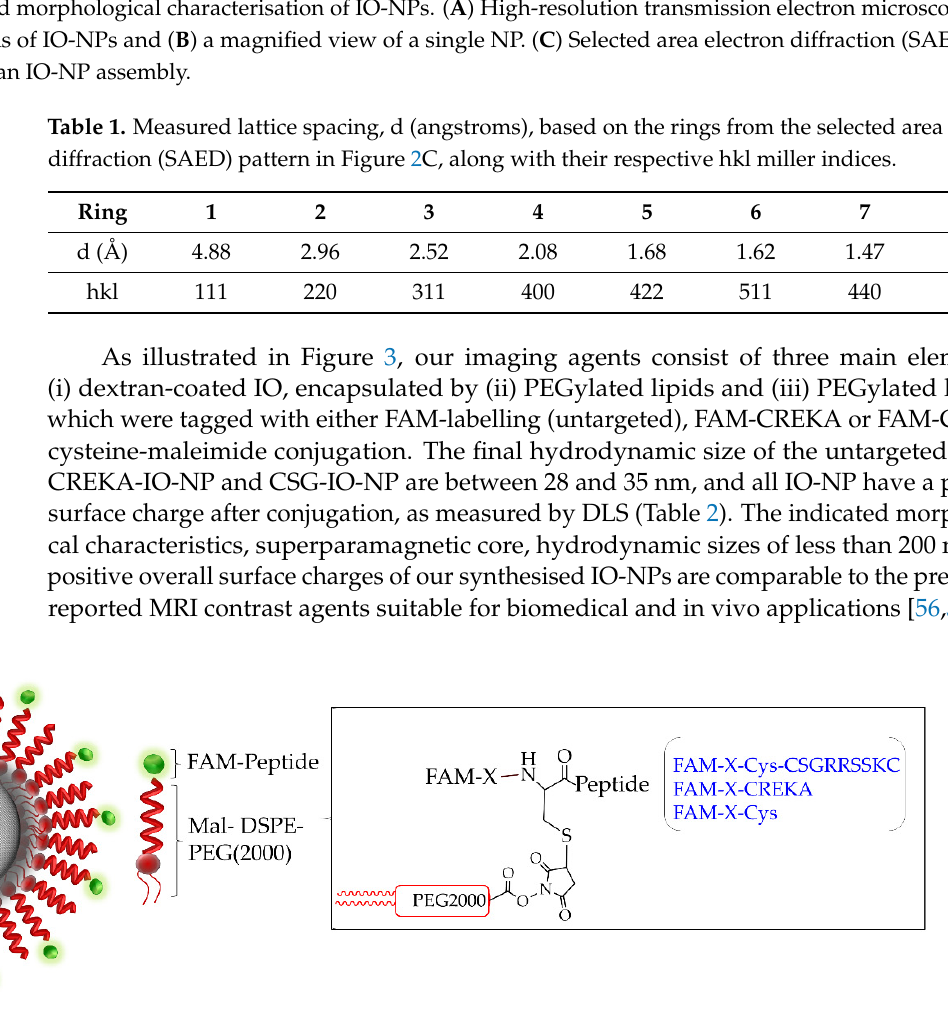
Figure 3. Schematic illustration of IO-NP consisting of a dextran-coated IO particle (core, gray) encapsulated by DSPE-PEG2000 lipids (in red) with the lipids tagged to a peptide or cysteine residue (in green). FAM-X- Cys-CSG (CSGRRSSKC), FAM-X-CREKA or FAM-X-Cys (untargeted) is tagged to the lipids via cysteine-maleimide (Mal) interaction (shown in the box). Table 2. IO-NP sizes and their zeta potentials as measured by dynamic light scattering (DLS).